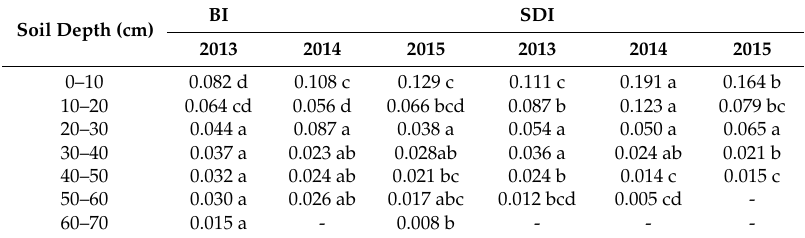
Table 6. The RBD (mg cm − 3 ) measured at different soil depths in 2013, 2014 and 2015. Abbreviations: BI, border irrigation; SDI, surface drip irrigation; and RBD, root biomass density. Letters indicate statistical significance at p = 0.05 level within the same row and the values are the means of three replicates. BI Soil Depth (cm)